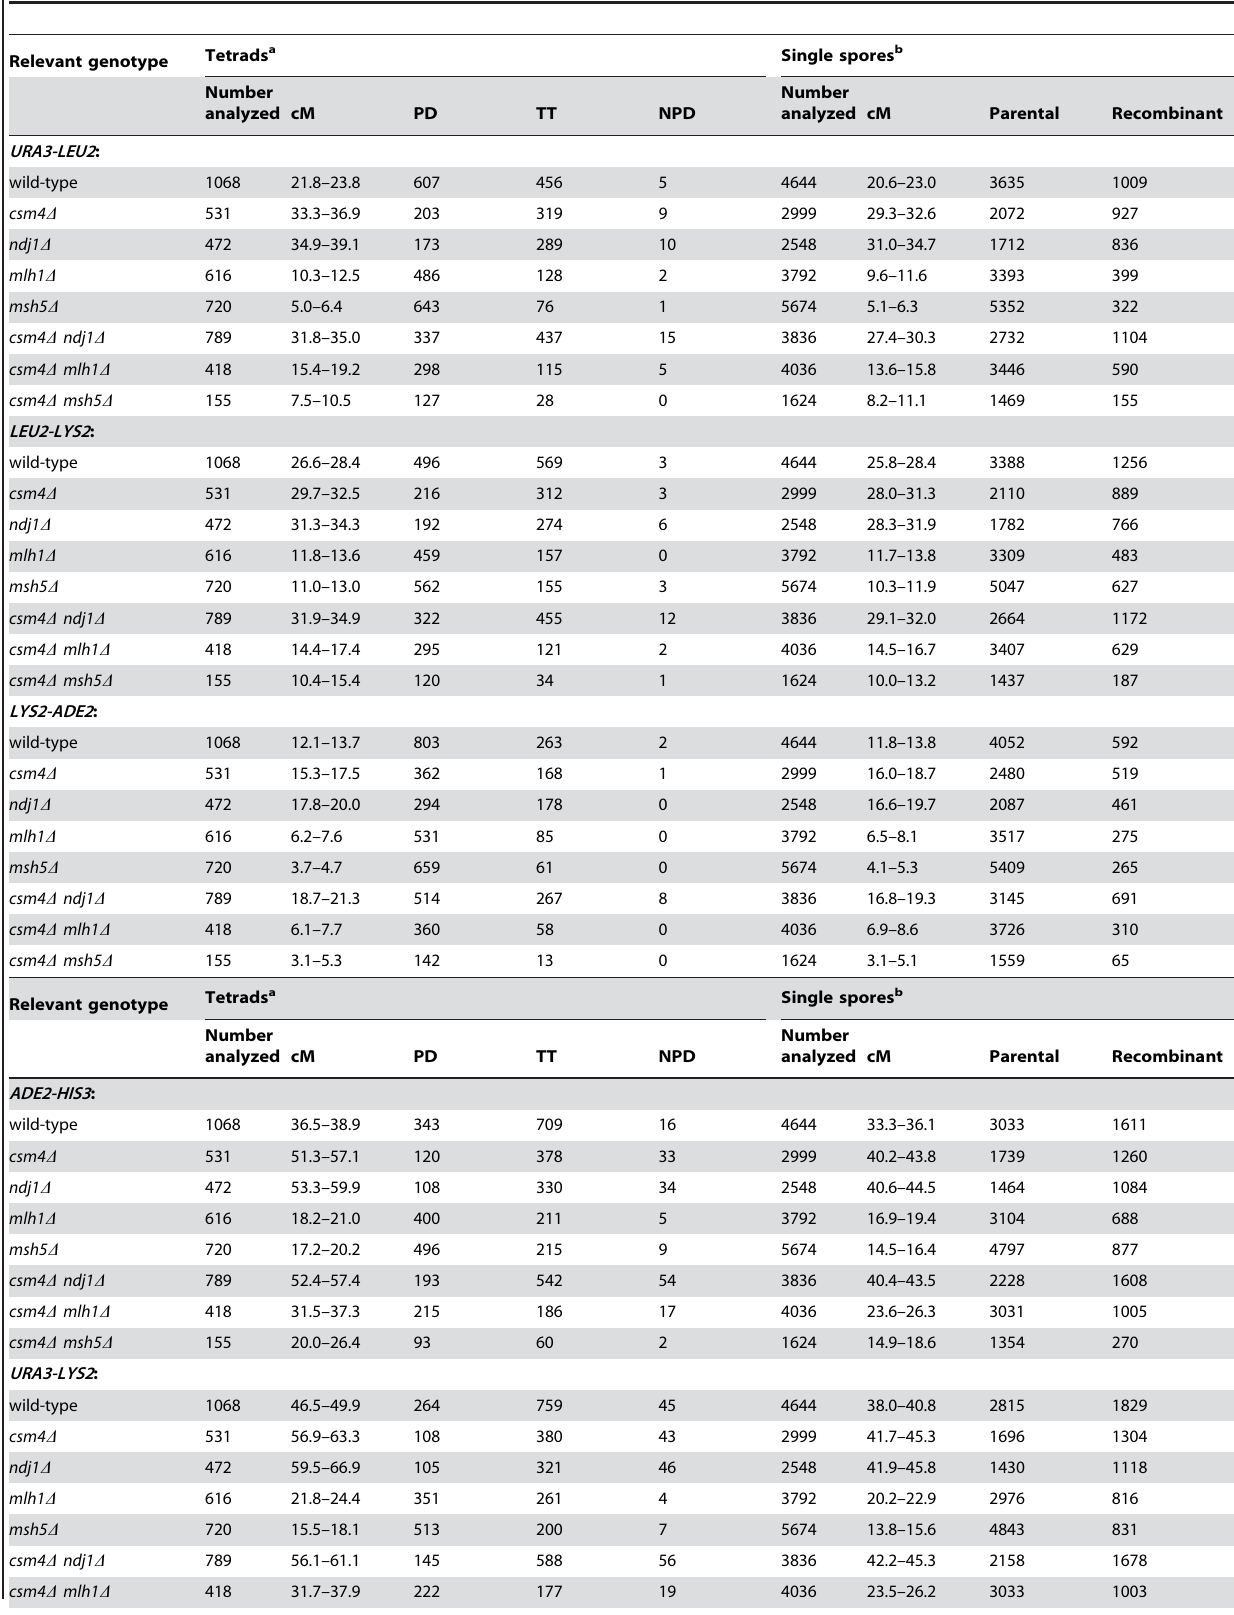
Table 1. Genetic map distances (cM) and the distribution of parental and recombinant progeny for the EAY1108/EAY1112